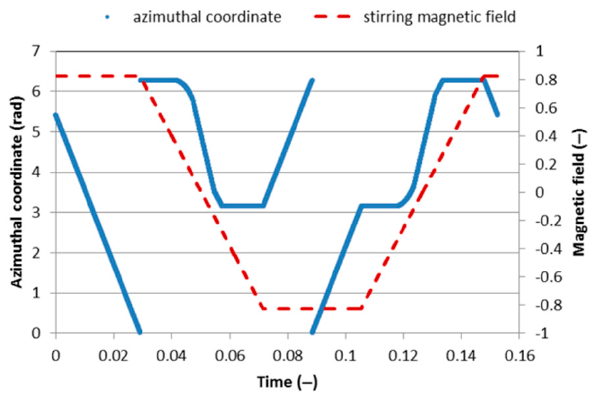
Figure 6. Time evolution during a stirring period of the azimuthal coordinate of the arc component R.